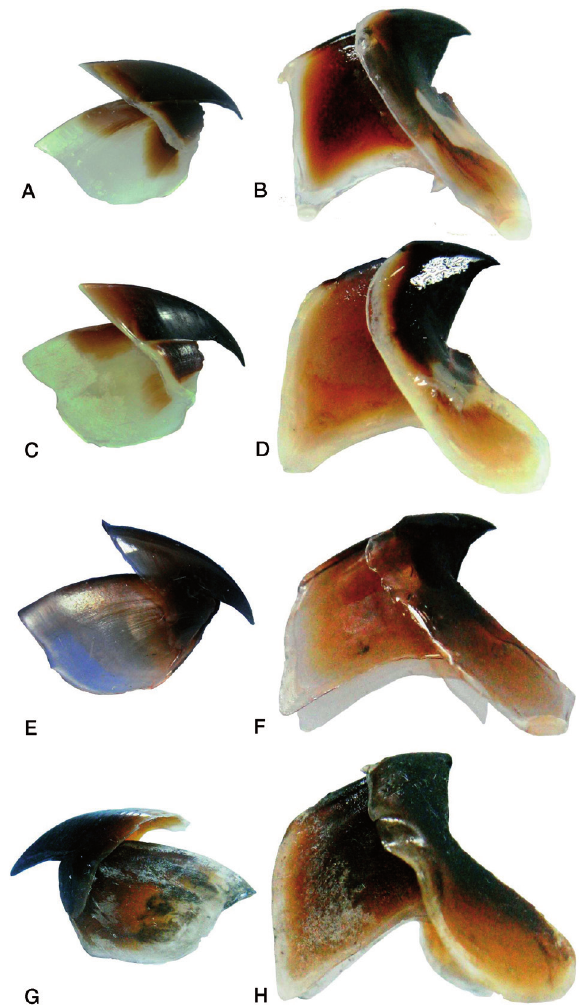
F Ig .1. – The photographs of the beaks of the four Ommastrephid species: A, upper beak and B, lower beak of O. bartramii ; C, upper beak and D, lower beak of D. gigas ; E, upper beak and F, lower beak of S. oualaniensis ; and G, upper beak and H, lower beak of I.